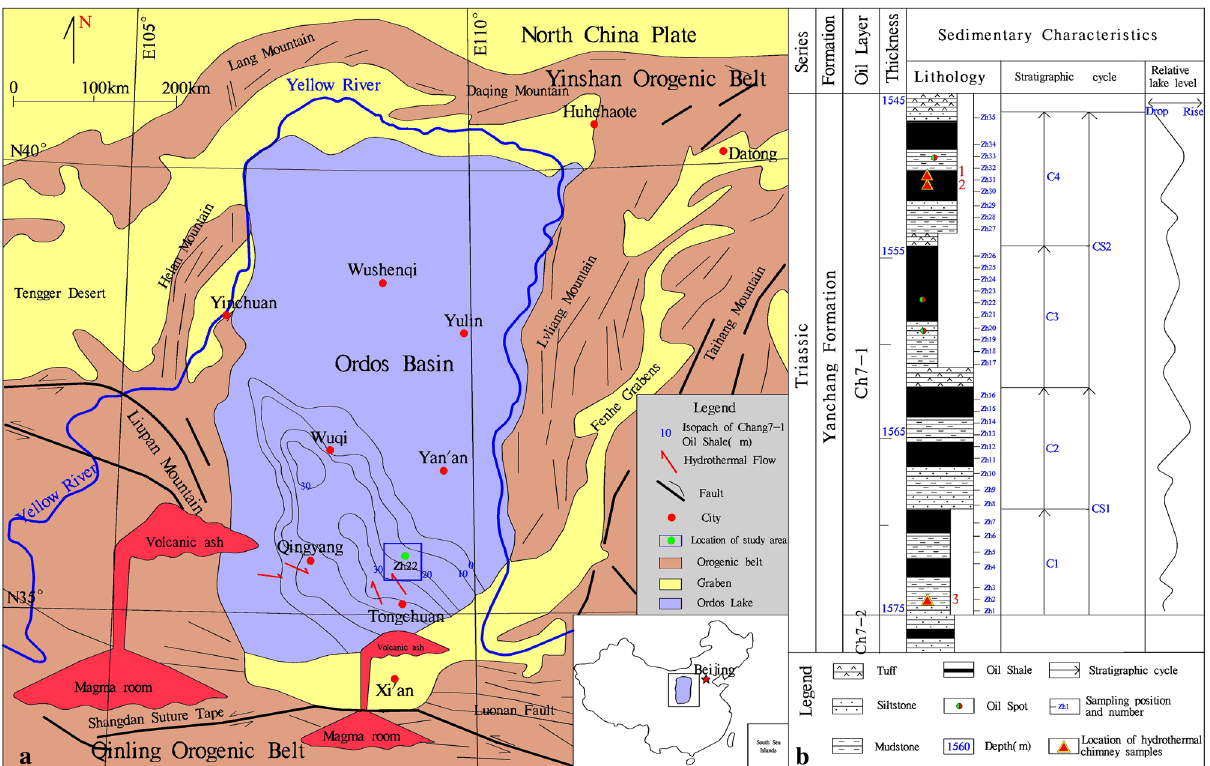
Figure 1. Regional geological map of the Ordos Basin and stratigraphic column with sampling positions (Map modified from reference 8 , and it is drawn with Mapgis6.7, version number is 6.7, the map from URL